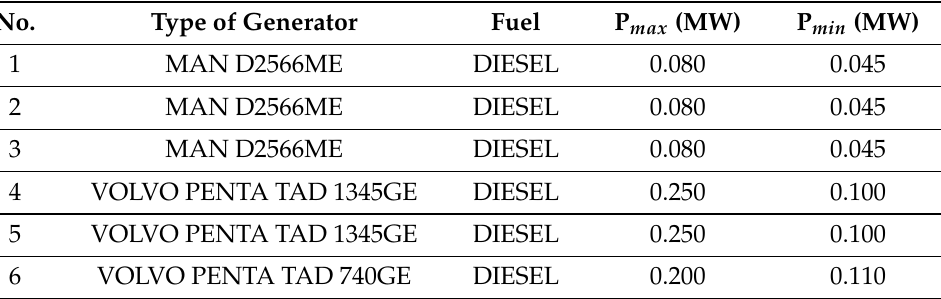
Figure 2. Annual load of Donoussa and Data-Map of the monthly load profile. Donoussa is one of the 32 greek NIIs. Its energy system is mainly based on one diesel power plant for the production of electricity, without the use of RES so far. The types of generators used in the thermal plant and their characteristics can be seen in the Table 1. The sum of output power of all generators is 0.940 MW and the total production for the year 2017 according to HEDNO was 1012.66 MWh. The average annual variable fuel cost of conventional units is 250.02 (cid:68) /MWh for 2017 and the average annual additional operating and maintenance cost was estimated to 4.04 (cid:68) /MWh. The total cost, which includes fuel cost, operating and maintenance cost, amortization of capital, interest payment and auxillary cost for the conventional system power plant was 662.71 (cid:68) /MWh. Table 1. Types of generators and their characteristics of Donoussa thermal plant provided by HEDNO